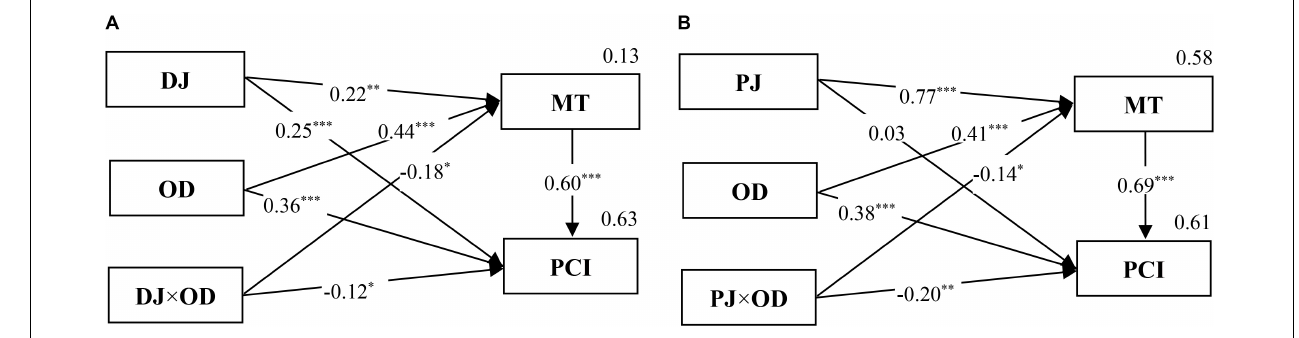
FIGURE 6 | The mediated moderation model of DJ (A) , PJ (B) , OD, and MT on PCI (Study 1). n = 320; ∗∗∗ p < 0.001, ∗∗ p < 0.01, ∗ p < 0.05.